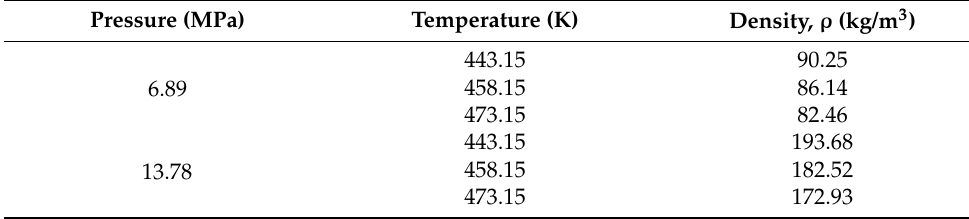
Table 9. Densities of CO 2 at different temperatures and pressures obtained by PR